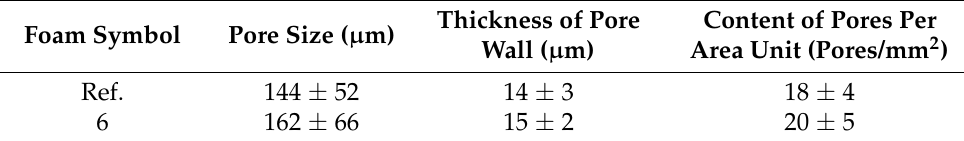
Figure 3. Micrographs of cellular structure of foams based on: ( A ) MSA-based polyol; ( B ) mixture of MSA- and PLA-based polyols. Table 3. Results of statistical analysis of SEM